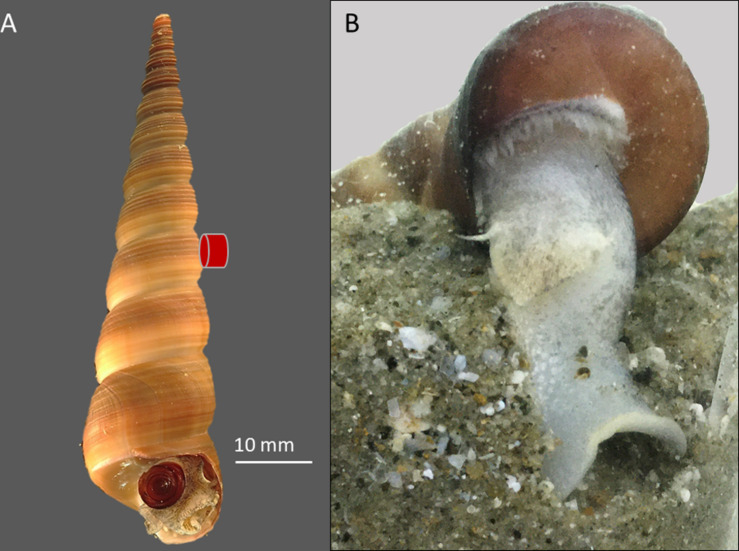
(A)
Turritella bacillum photgraphed in air, showing retracted head-foot and operculum centrally in the aperture; this is also the assumed posture during sediment feeding. (B) Snail burrowing in a glass tank in the laboratory, showing extrusion and probing of the foot. The red symbol indicates the position of the IR sensor used to detect heartbeat.